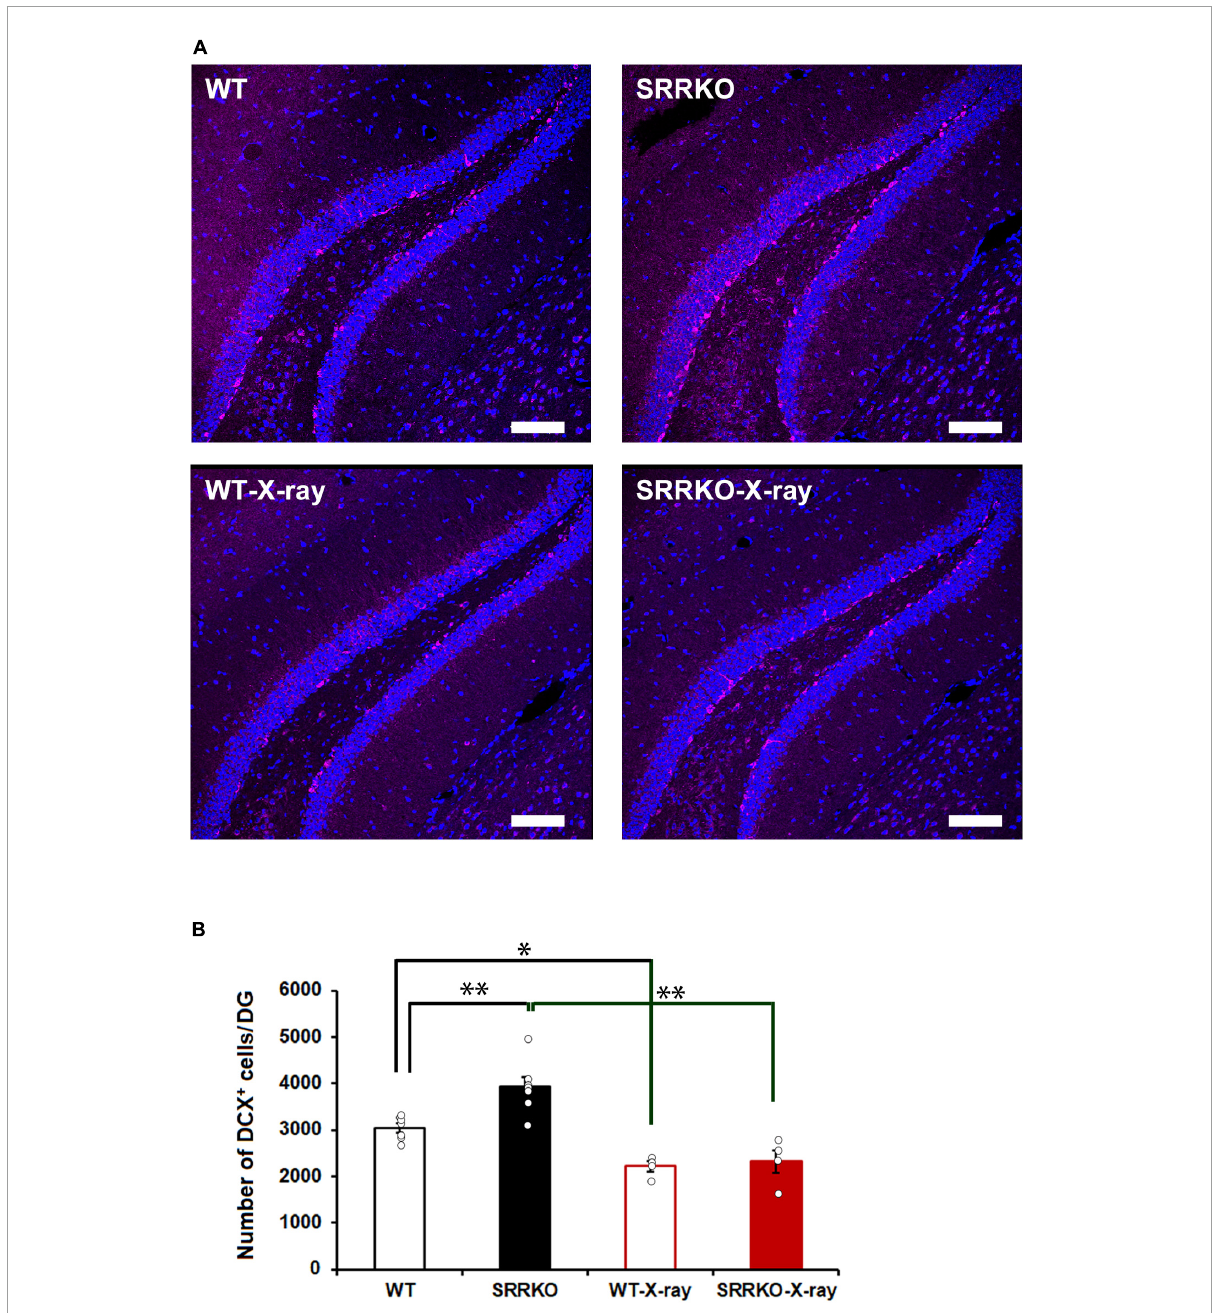
FIGURE2 Effects of X-ray irradiation on adult hippocampal neurogenesis. (A) Immediately after the fourth retrieval on day 28, mouse brains of the four groups, WT, WT-X-ray, SRRKO, and SRRKO-X-ray, were removed and stained using anti-doublecortin (DCX) antibody (magenta) and DRAQ5 (blue). Scale bars, 100 µ m. (B) Quantification of DCX-positive (DCX + ) cells in the dentate gyrus (DG) of WT and SRRKO mice with or without X-ray irradiation (WT, n = 7; SRRKO, n = 7; WT-X-ray, n = 4; SRRKO-X-ray, n = 4). Data are presented as the means ± SEM. ∗ p < 0.05, ∗∗ p <